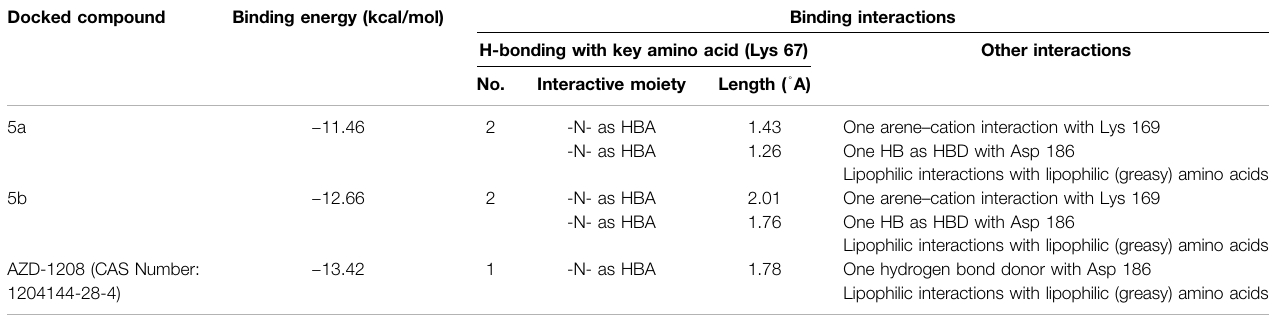
Two-dimensional interactions of docked compounds 5a ( A ), 5b ( B ), and standard Pim-1 inhibitor AZD-1208 ( C ). a RMDS value for self-docking (cid:2) 0.73 (lower than 2), which validates the MOE docking calculation for the tested compounds. # The docking results for the other tested compounds are supported as